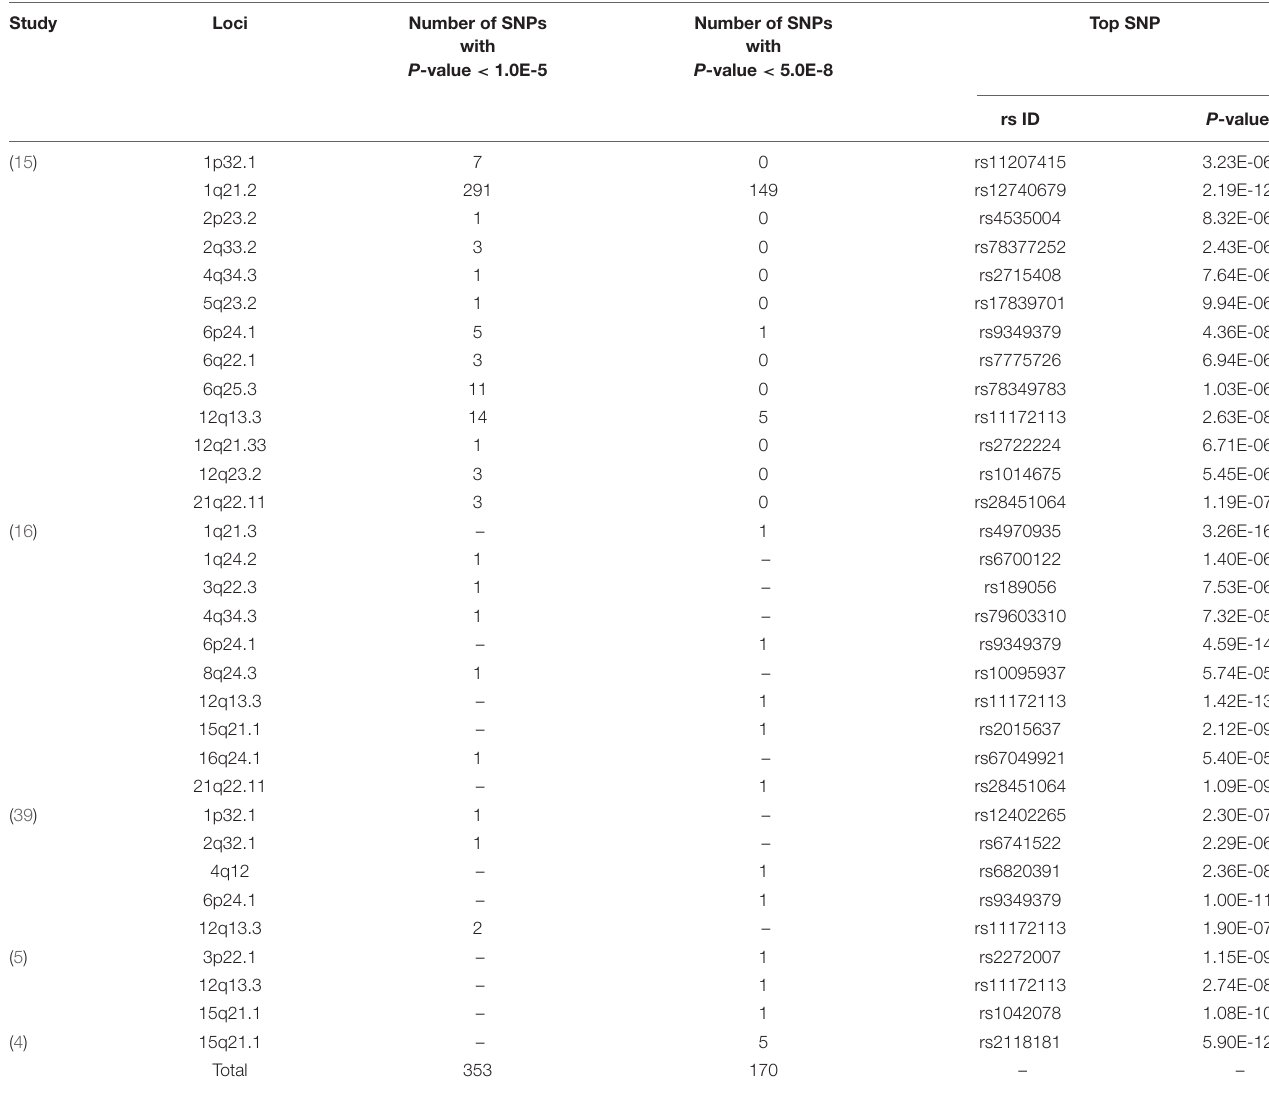
TABLE 1 | The SCAD loci collected from